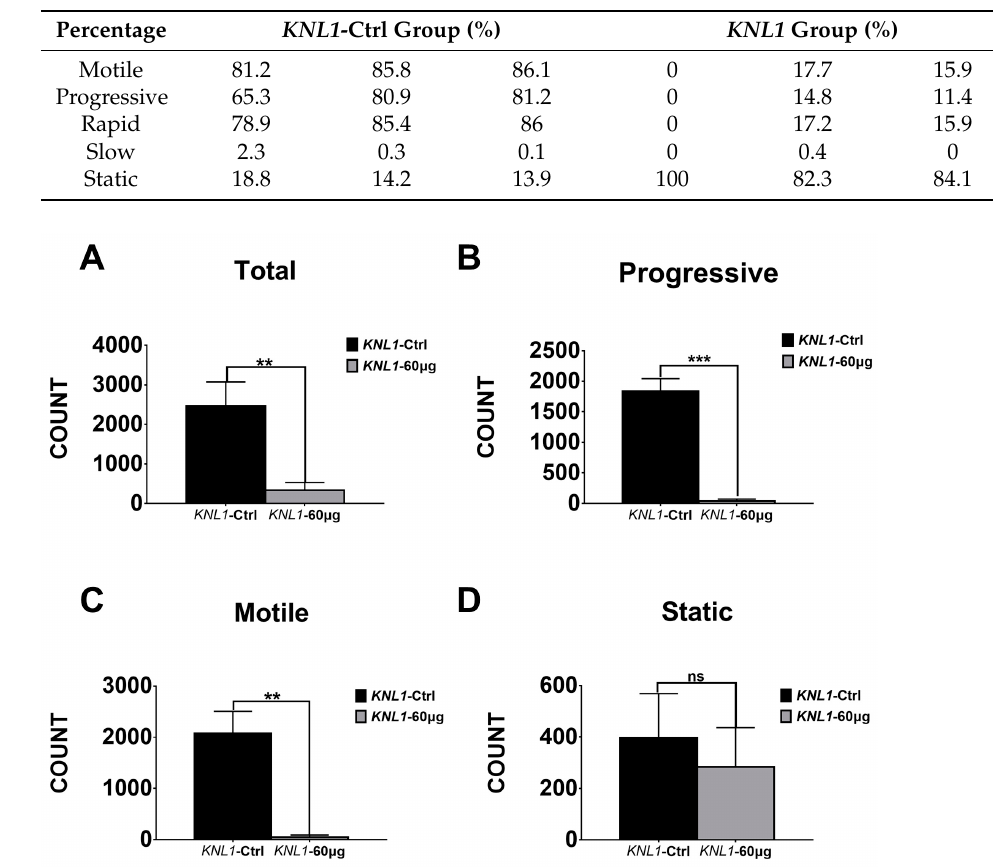
Figure 4. The CASA data of KNL1 -Ctrl and KNL1 -60 µ g Group mice. ( A ) CASA total detection of KNL1 -Ctrl and KNL1 -60 µ g. ( B ) CASA progressive detection of KNL1 -Ctrl and KNL1 -60 µ g. ( C ) CASA motile detection of KNL1 -Ctrl and KNL1 -60 µ g. ( D ) CASA static detection of KNL1 -Ctrl and KNL1 -60 µ g. Asterisk denotes statistical difference level of significance (**, p < 0.01; ***, p < 0.001, ns > 0.05).